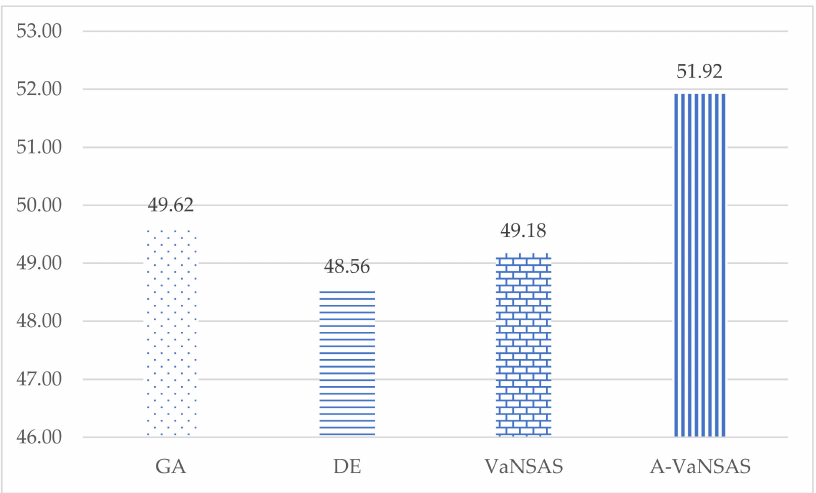
Figure 11. Percentage of drought risk area using various solution